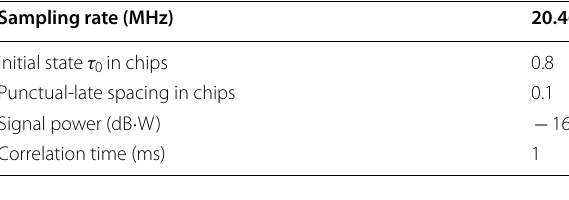
Table 1 Simulation parameters